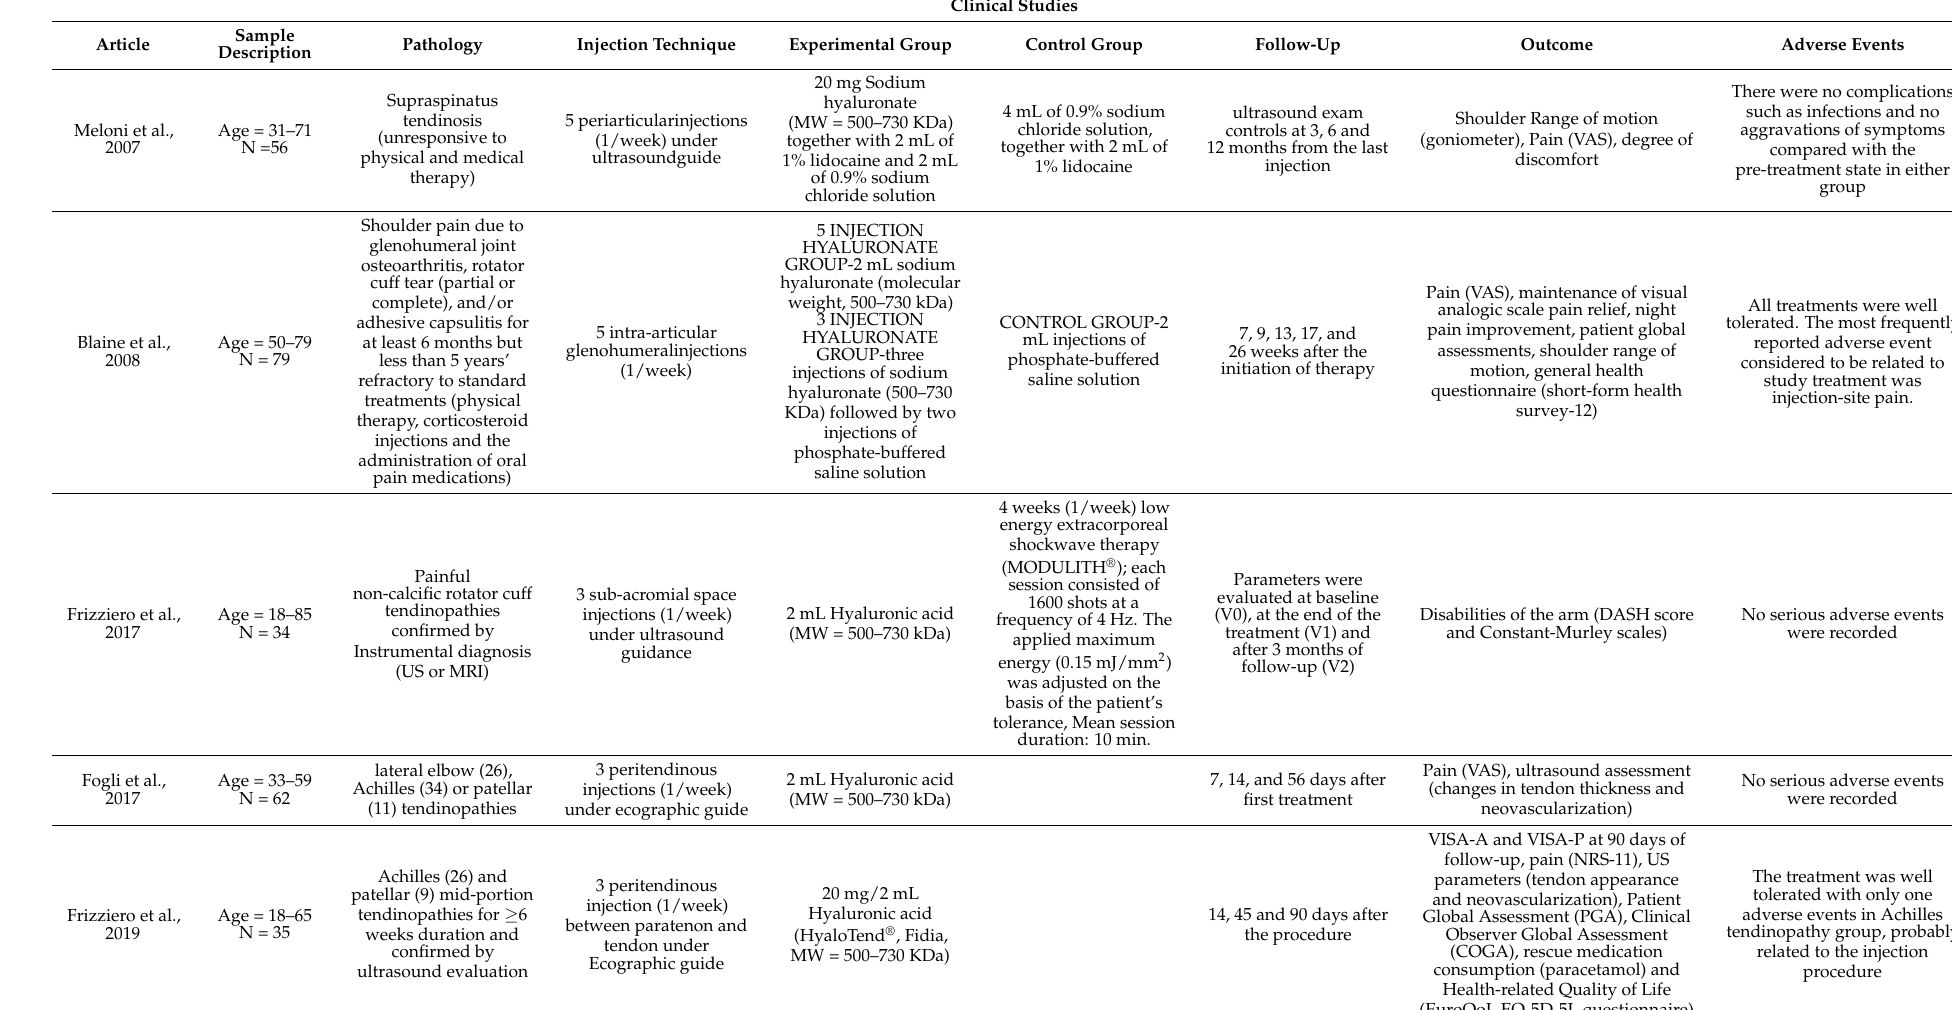
Table 2. Eight papers about clinical studies were selected from literature